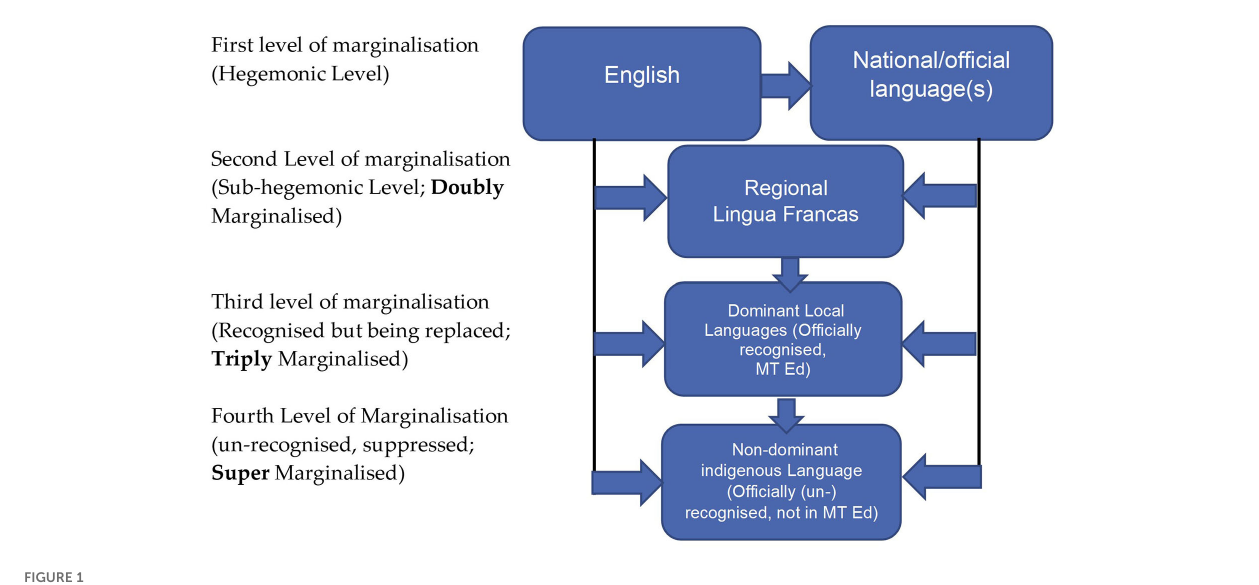
FIGURE1 Layers/levels of linguistic